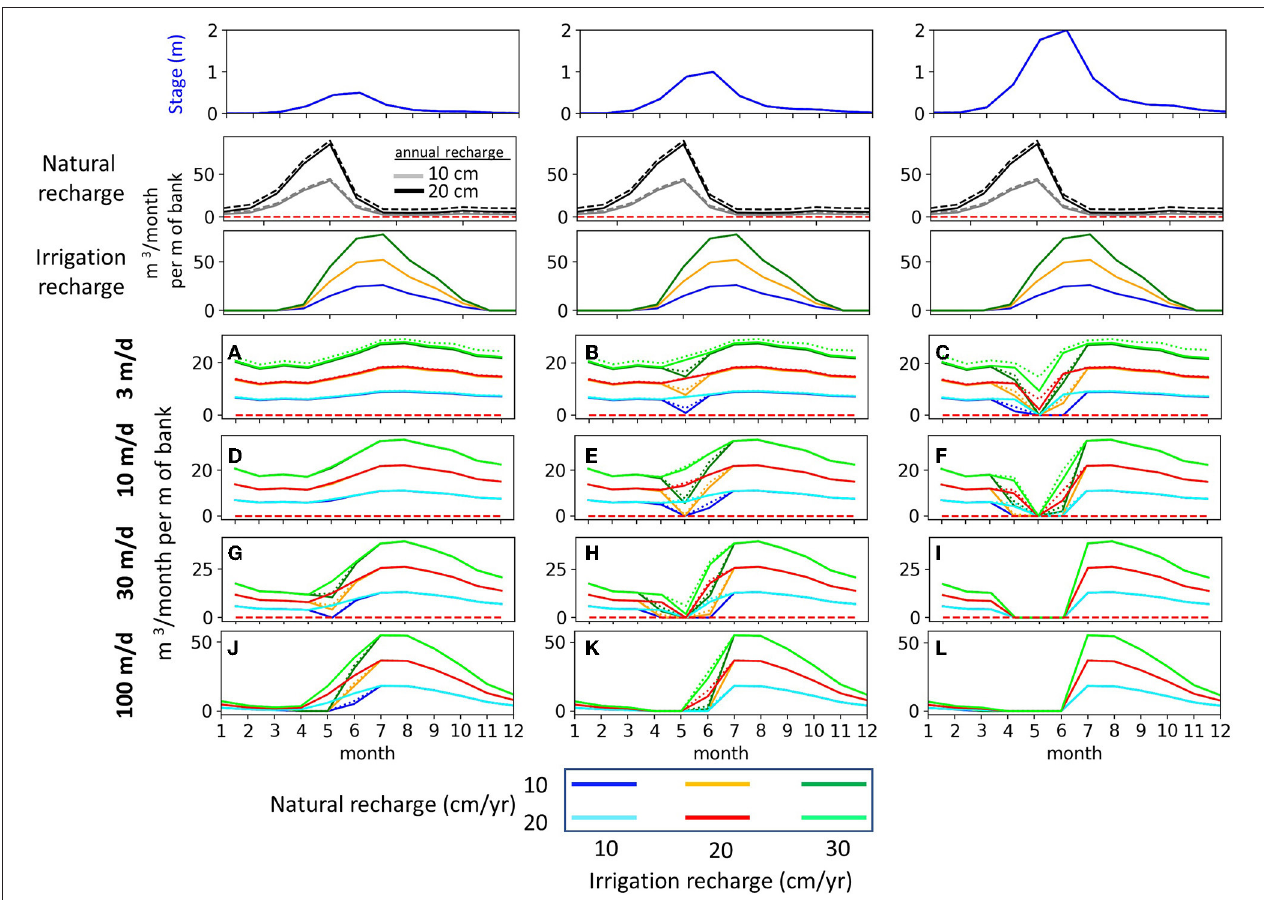
FIGURE 9 | Return flow for simulation Group 3. The first three rows show, respectively, the corresponding transient stage, natural recharge, and irrigation recharge patterns. The three irrigation recharge magnitudes are denoted by the green/lime (30 cm/yr), orange/red (20 cm/yr), and blue/cyan (10 cm/yr) with each color pair corresponding to the two different natural recharge magnitudes as shown in the legend. The dotted vs. solid lines in subplots A-L denote the two constant mountain block recharge flux rates (dashed = 50% and solid = 25% of net annual recharge). Subplots (A,D,G,J) correspond are for a 0.5 m stage amplitude, (B,E,H,K) are for 1 m amplitude, and (C,F,I,L) are for 2 m amplitude.